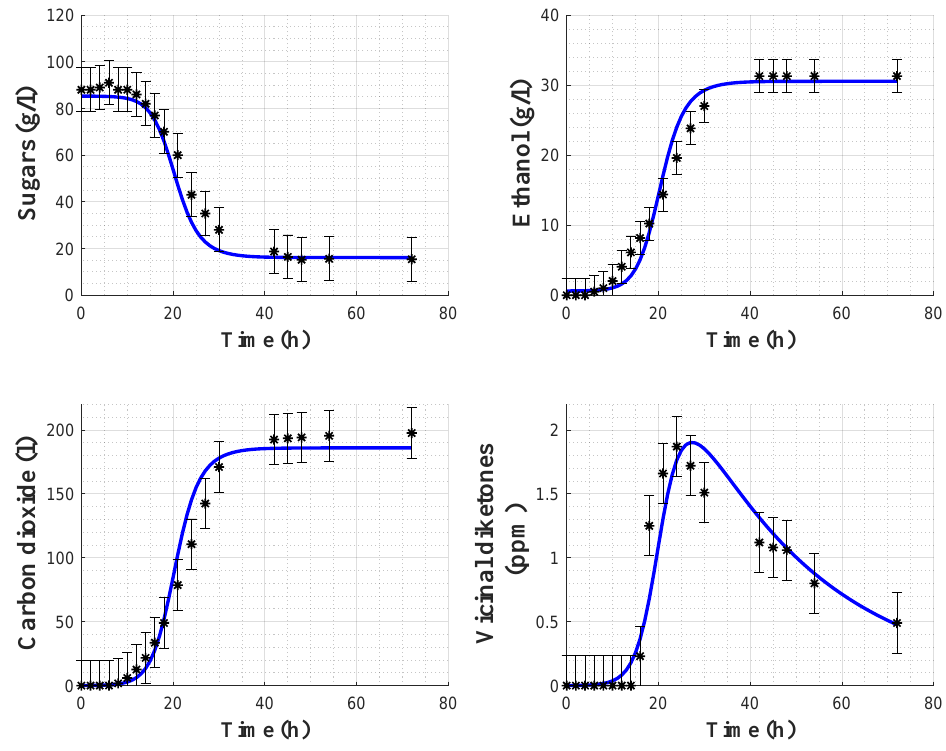
Figure 7. Cross-validation of the carbon dioxide model with the data from experiment 1. Stars: experimental data. Error bars: 95% confidence intervals. Continuous blue line: model